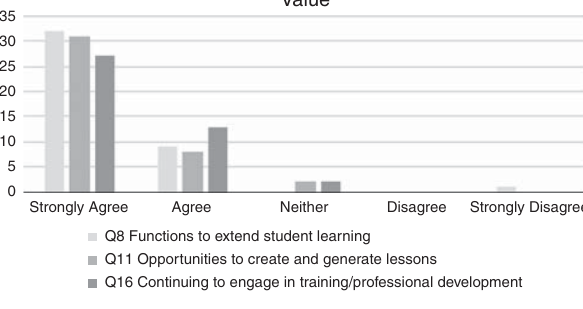
Figure 3. Participants